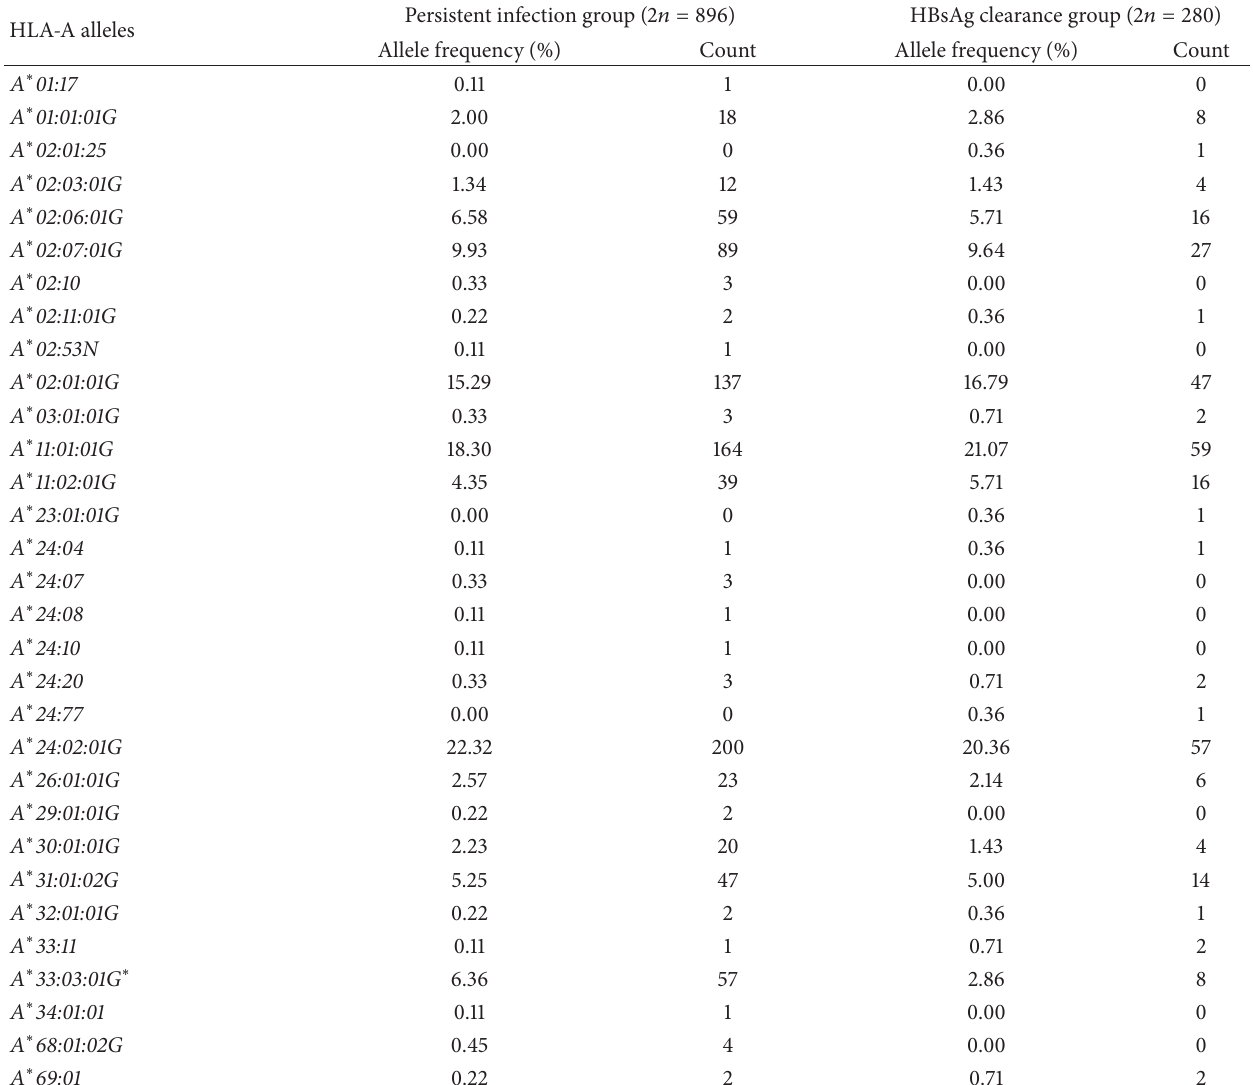
Table 1: Frequencies of HLA-A alleles in each study group.